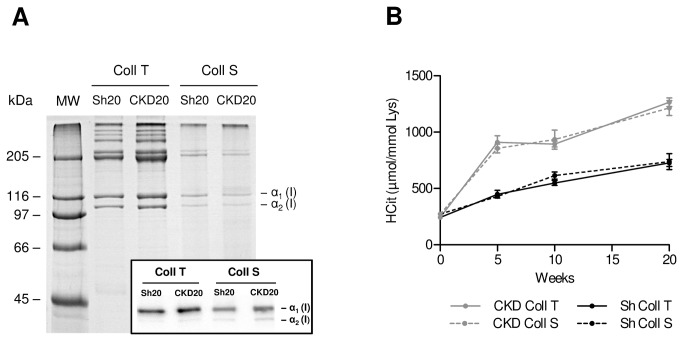
Carbamylation of collagen in CKD mice.(A) SDS-PAGE of collagen extracted from the skin (Coll S) and tail tendons (Coll T). Insert: Western blot of purified collagen. (B) Kinetics of carbamylated collagen accumulation in the tail tendons (CKD Coll T) and skin (CKD Coll S) of the CKD group compared to the sham operated group (ShSh Coll T and ShSh Coll S). Collagen carbamylation was evaluated by homocitrulline quantification, expressed in μmol/mol of lysine. Each dot represents the mean value of the 10 mice in the group.